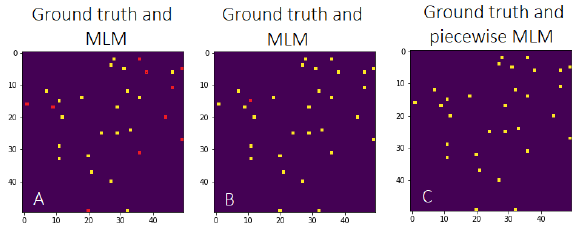
Figure 6: The joint anomaly detection maps of the ground truth and the MLM for the ColorChecker dataset. Yellow represents detected anomalies. Red spots are undetected local anomalies.